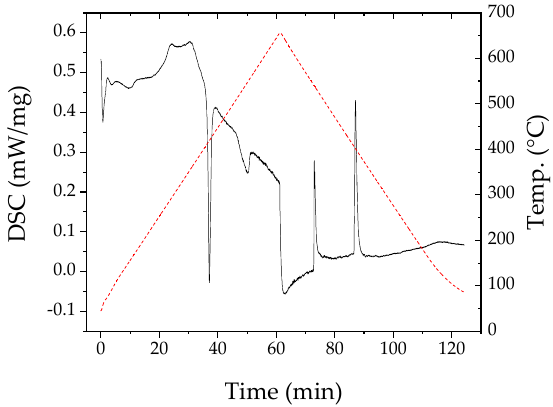
Figure 2. Differential scanning calorimetry (DSC) results for dry p-type paste (red dotted line shows temperature curve).